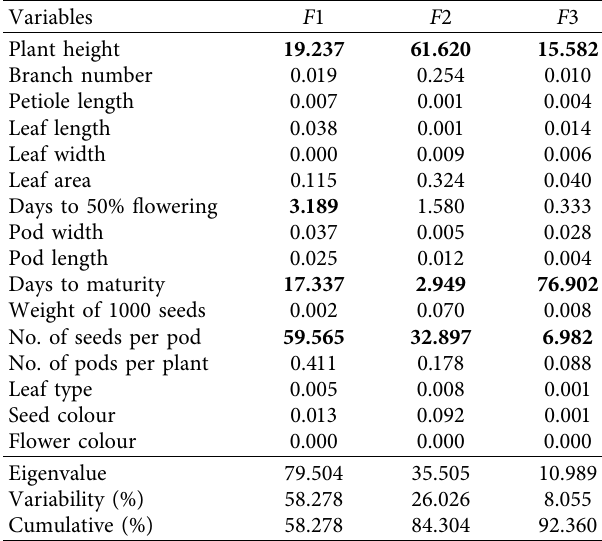
Table 5: Contribution of the variables to the first three diversity